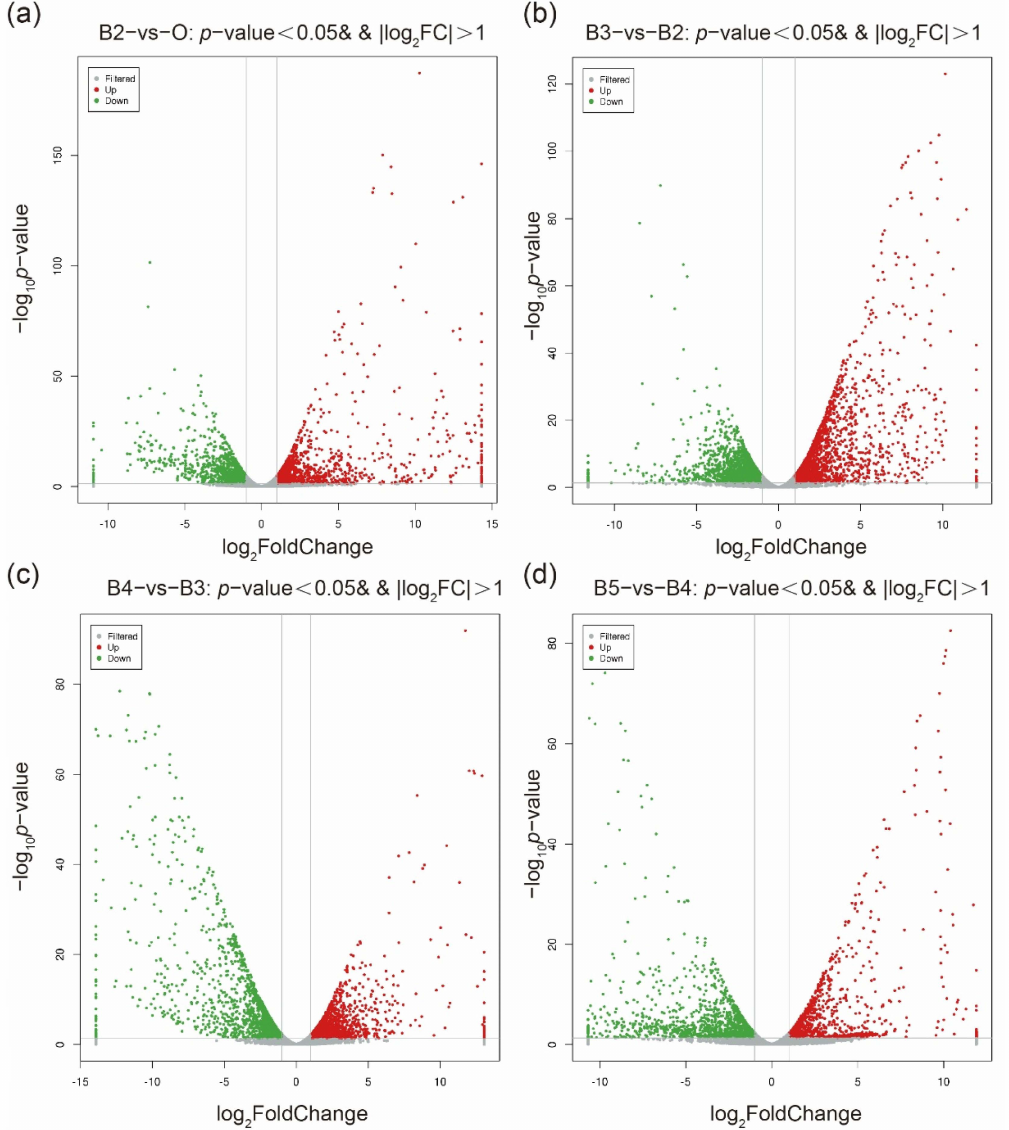
Figure 1. Development-associated transcriptomic profiles across the postembryonic development from the first larval instar to pupa of S. peregrina . In relation to the numbers of differentially expressed genes (DEGs), the up-regulated genes were represented by a red dot, and the down-regulated genes were represented by a blue dot. ( a ) B2 vs. O, ( b ) B3 vs. B2, ( c ) B4 vs. B3, ( d ) B5 vs.